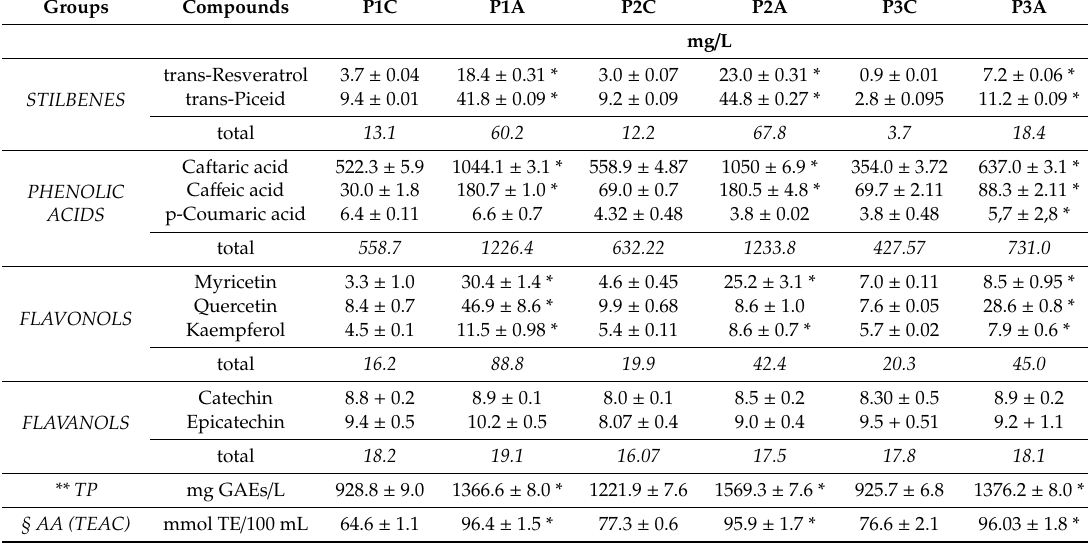
Table2. Comparisonofdi ff erentclassesofpolyphenolscontentinPrimitivowineestracts(PC)fermented with commercial yeast and Primitivo wine extracts obtained by utilizing selected autochthonous yeast strain (PA). Comparison of Total Phenolics content (TP) and Antioxidant Activity (AA) in Primitivo wine extracts (PC and PA). Values reported in the table are the mean ± SD of three